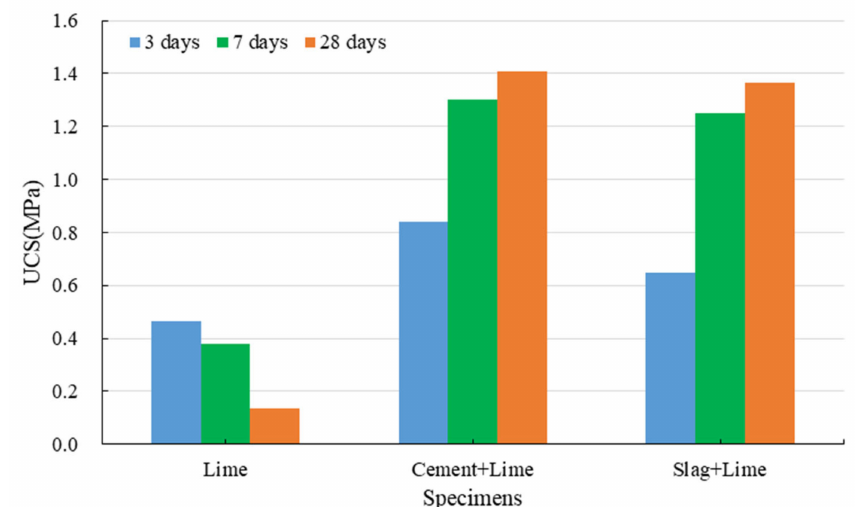
Figure 8. Strength development of red mud-based CPB with